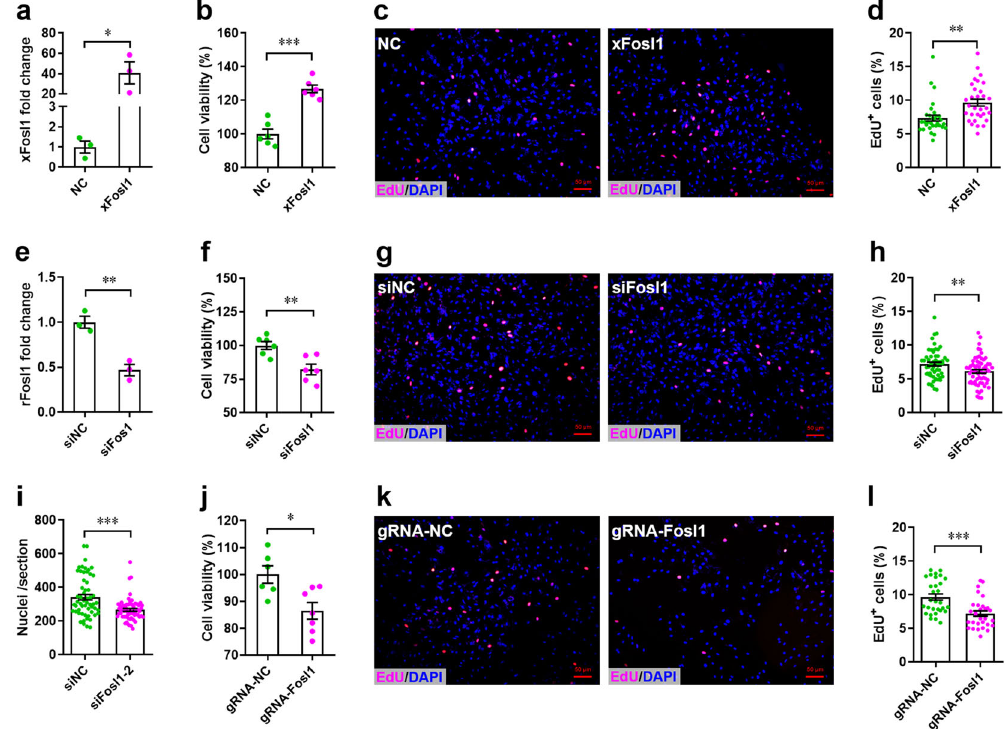
Fig. 6 Fosl1 is critical to the proliferation of H9c2 cells. a – d H9c2 cells were transfected with pLOX-xFosl1 or pLOX-NC for 48 h, followed by qPCR validation of X. tropicalis Fosl1 ( xFosl1 ) expression ( a , n = 3 each), cell counting assay ( b , n = 6 each), and nuclear EdU incorporation assay, respectively. Representative images ( c ) and quanti fi cation ( d ) of EdU + cells are shown ( n = ~30 fi elds from 5 wells per group). e – i Endogenous rat Fosl1 (rFosl1) expression in H9c2 cells was silenced using siRNA for 48 h, followed by qPCR validation ( e ), cell counting assay ( f ), and EdU incorporation assay. Representative images ( g ) and quanti fi cation ( h ) of EdU + cells as well as quanti fi cation of total cells ( i ) are shown ( n = ~60 fi elds from 10 wells per group). j – l Stable Fosl1 knockdown H9c2 cell line was established using LentiCRISPRv2 system. Cell counting assay ( j , n = 6 – 7 each), representative images ( k ), and quanti fi cation ( l ) of EdU + cells are shown ( n = ~30 fi elds from 5 wells per group). All data are presented as mean ± SEM. * p < 0.05, ** p < 0.01, *** p < 0.001 (Student ’ s t